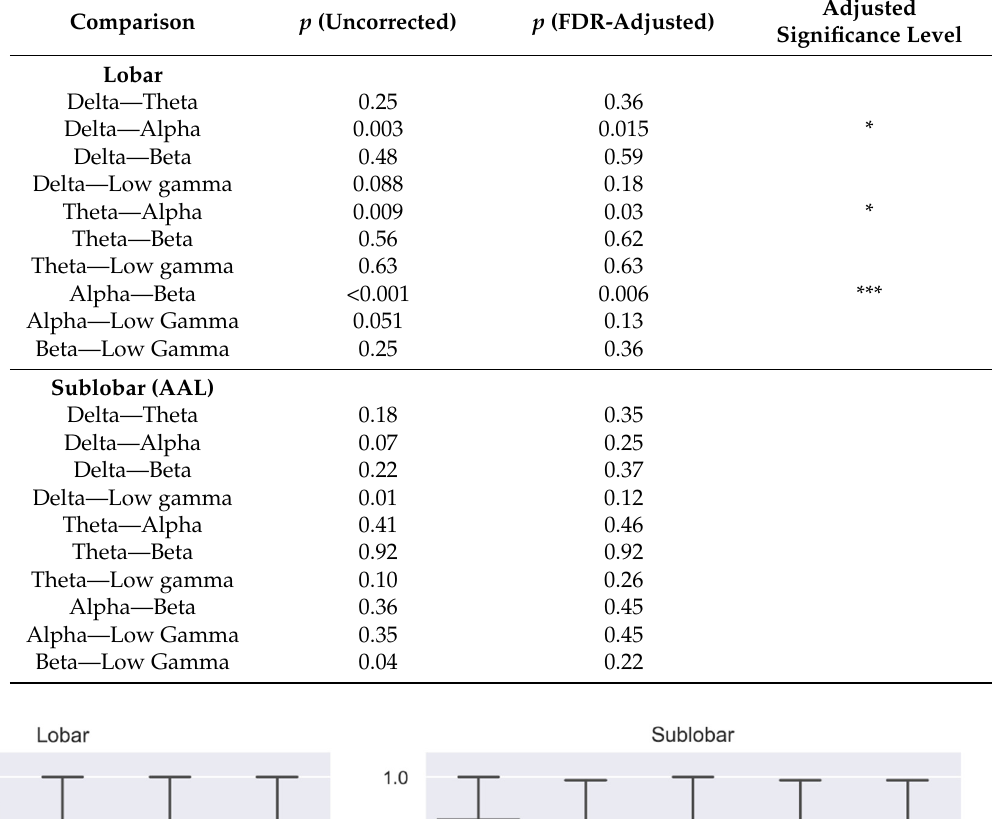
Table 4. Comparison of frequency band localization performance of node degree values for invasive